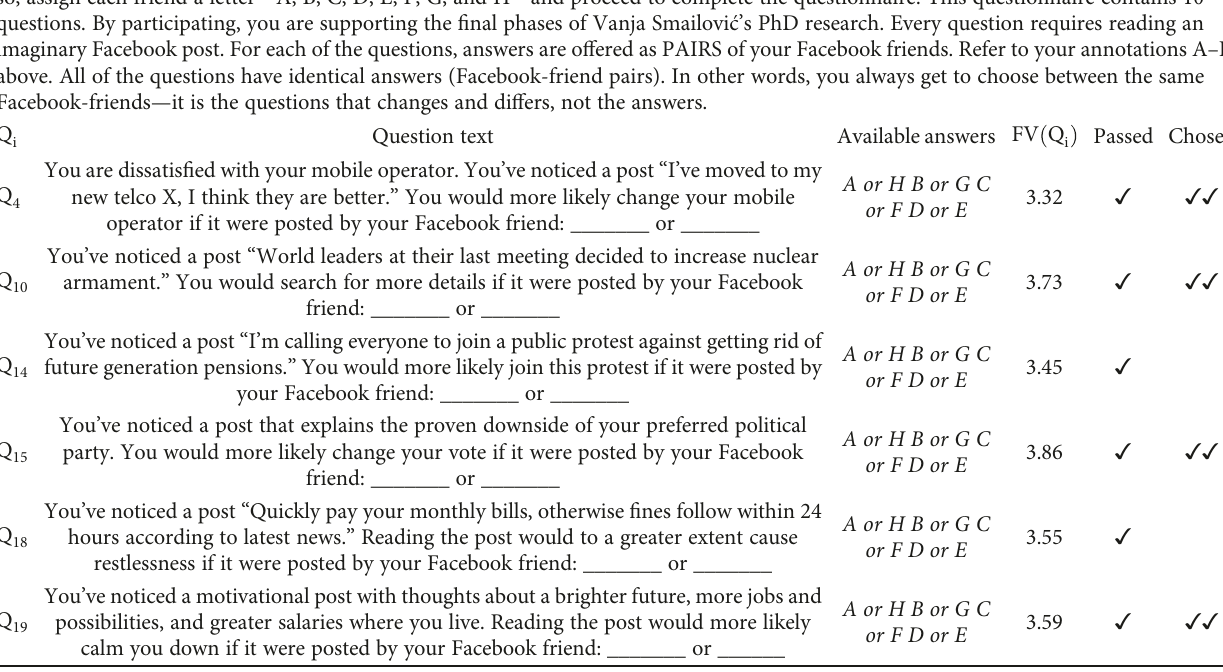
Table 6: Pre-questionnaire (face validity) given to